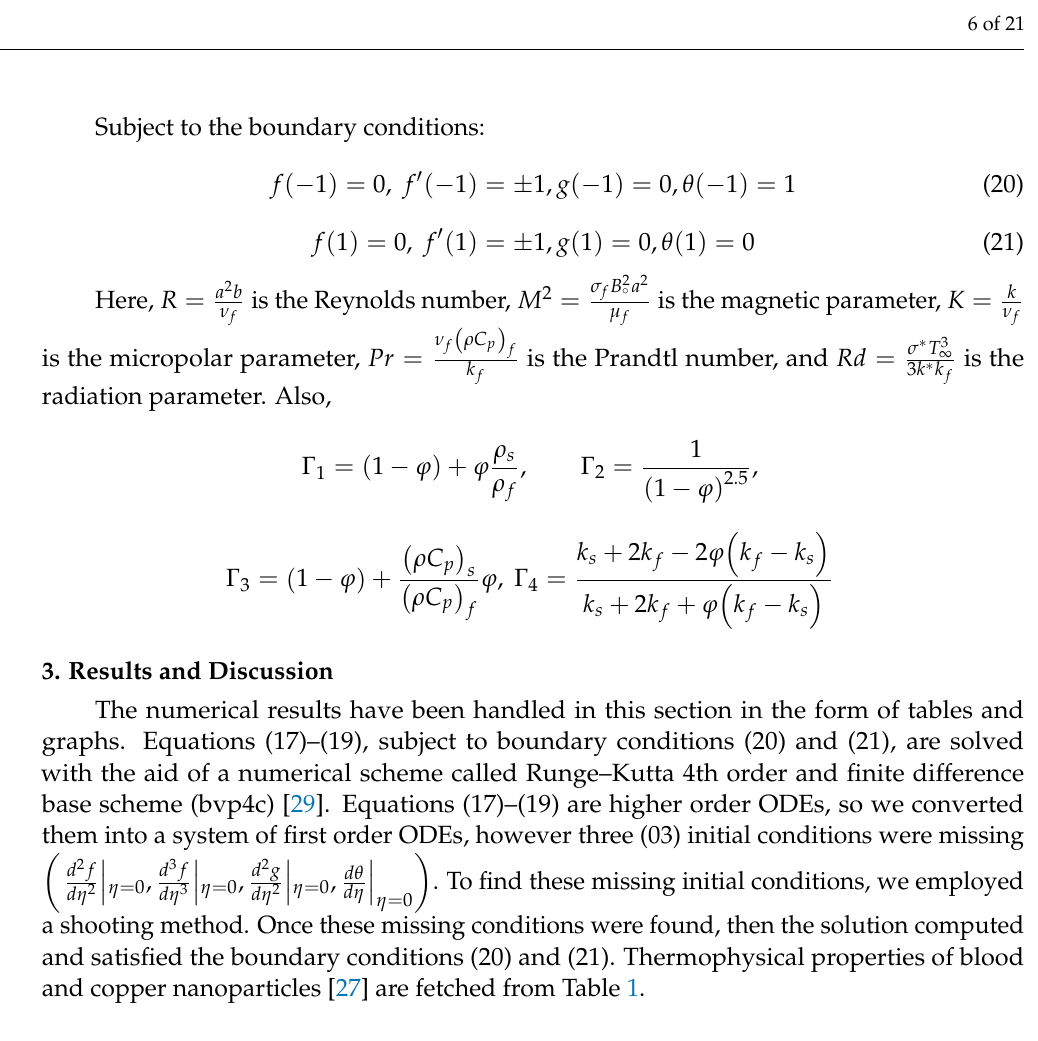
Table 1. Thermophysical properties of the blood and copper nanoparticles (see [27]). Properties Blood Copper (cid:16) Kg (cid:17) 1150 8933 Density m 3